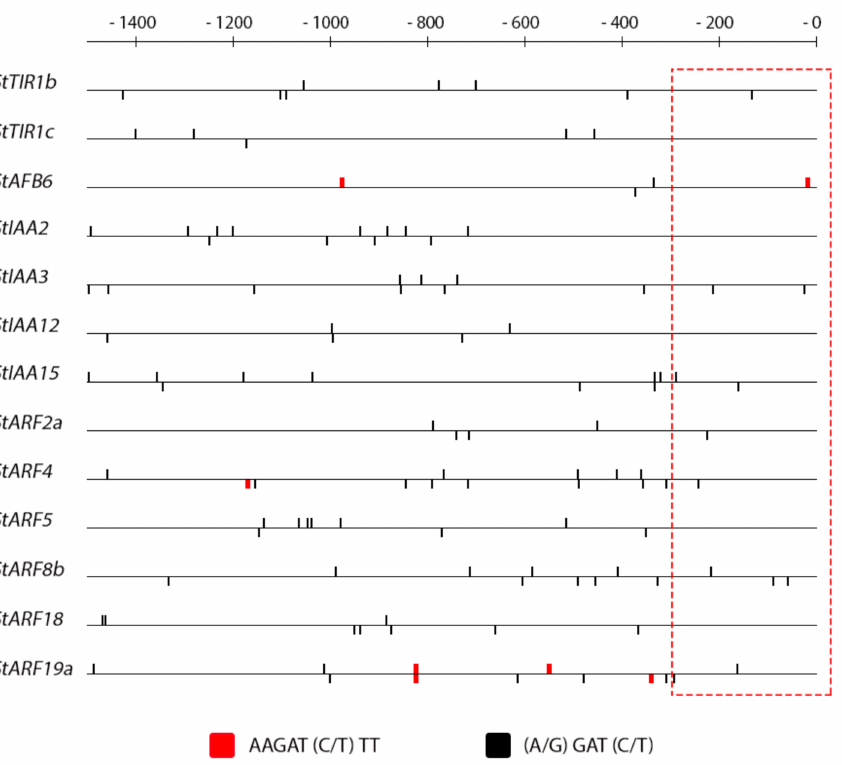
Figure 7. Pattern of CK-specific cis -elements (CREs) in promoters of auxin signaling potato genes. The scale on the top shows distance in bp upstream the transcription start. Presumable promoter zone rendering gene sensitive to CK is outlined by dotted red